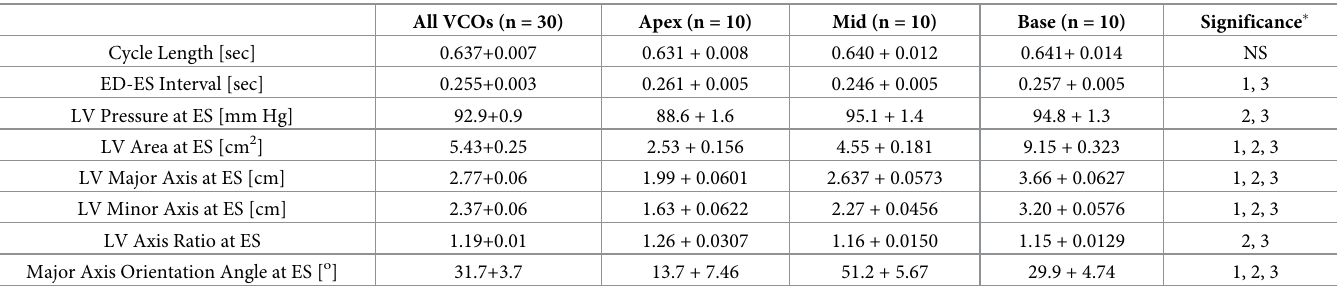
Table 1. Baseline cardiac MRI measurements.